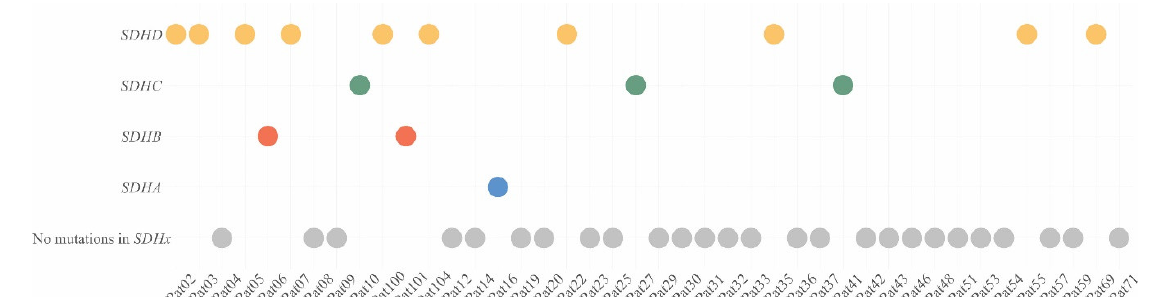
Figure 1. Distribution of SDHx variants in patients with CPGLs. Yellow dots—patients with SDHD variants, green dots—patients with SDHC variants, red dots—patients with SDHB variants, blue dot—patient with SDHA variant, grey dots—patients with no mutations in SDHx .